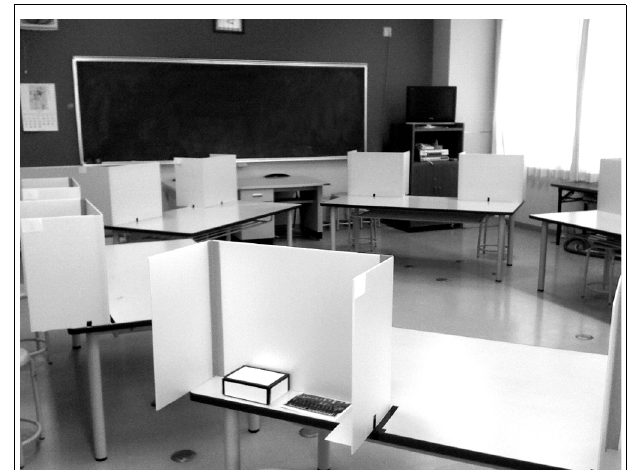
FIGURE 1 | Photograph of the top of a desk in the private condition (left, box with lid for the recipients’ chocolates; center, envelope for the child’s own chocolates and image of classmates; right, 10 chocolates).